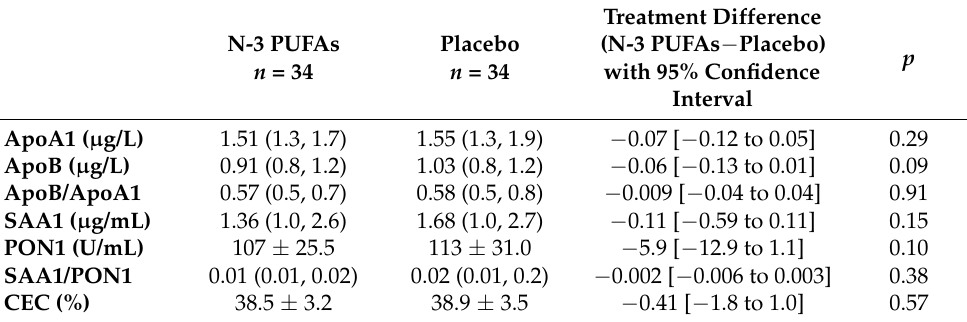
Table 4. Apolipoproteins and high-density lipoprotein function presented by